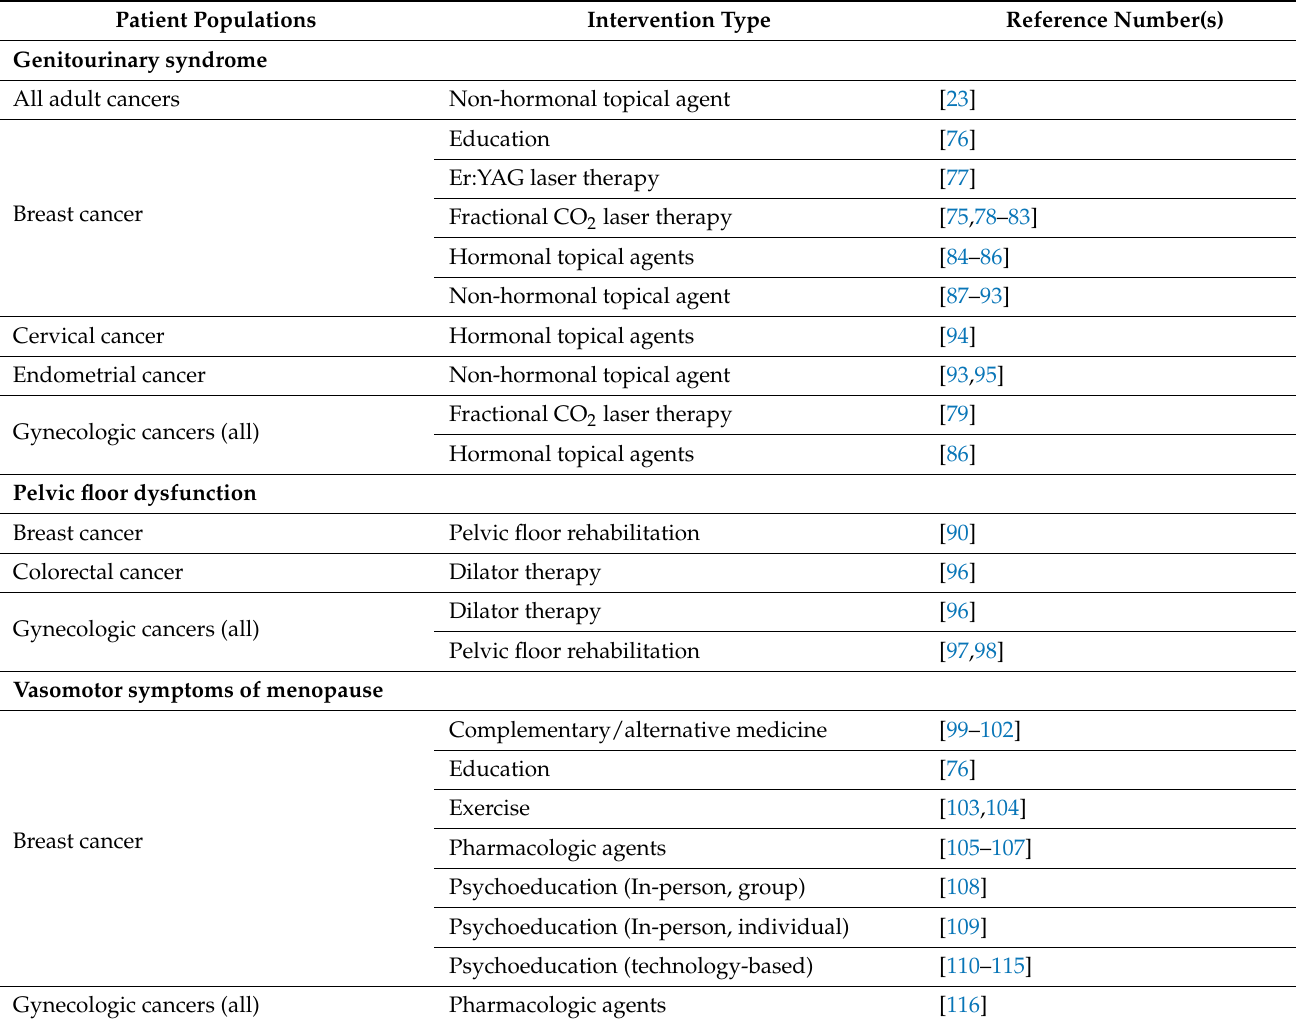
Table 2. Interventions to address genitourinary syndrome, pelvic floor dysfunction, and vasomotor symptoms of menopause in female cancer